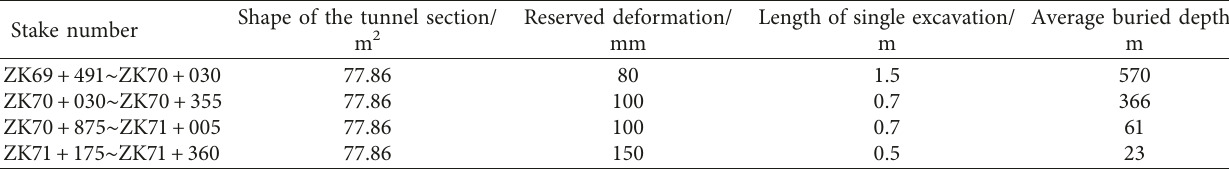
Figure 4: Geological profile of ZK70+700-ZK71+500 section. Table 4: Values of quantitative risk factors.